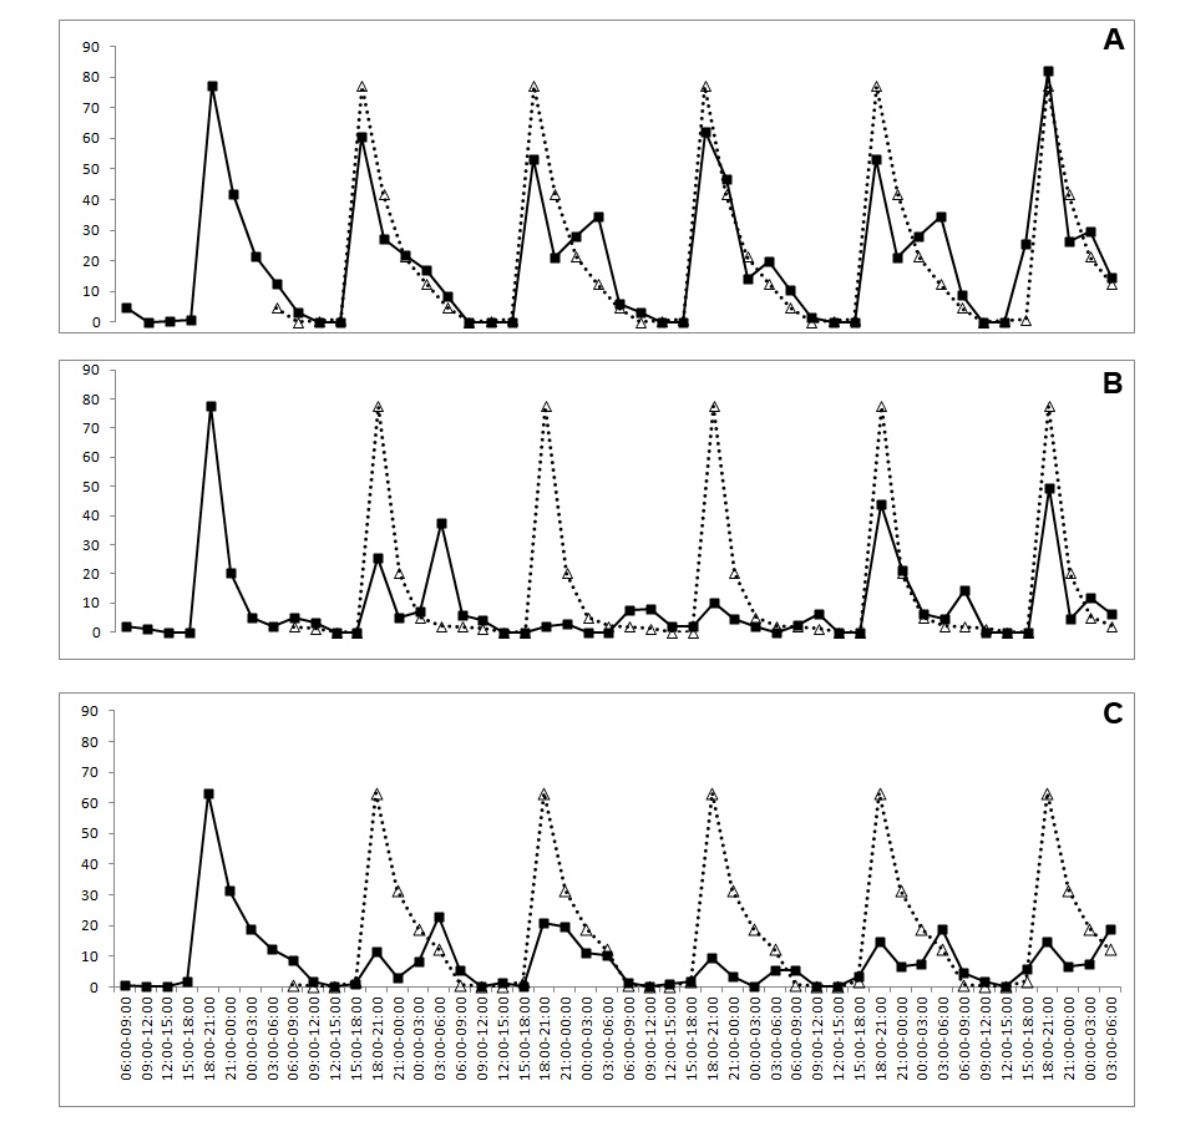
Figure 3. The difference in movement rates after feeding. Letters A , B and C in the figure present movement rates of animals that ingested 10, 20 and 40% of their own body weight,